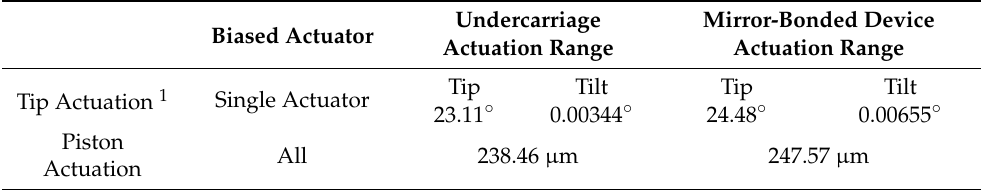
Table 3. Simulation results summary for the undercarriage and the mirror-bonded devices with a sine wave from 0 to 32 mA as the input signal.